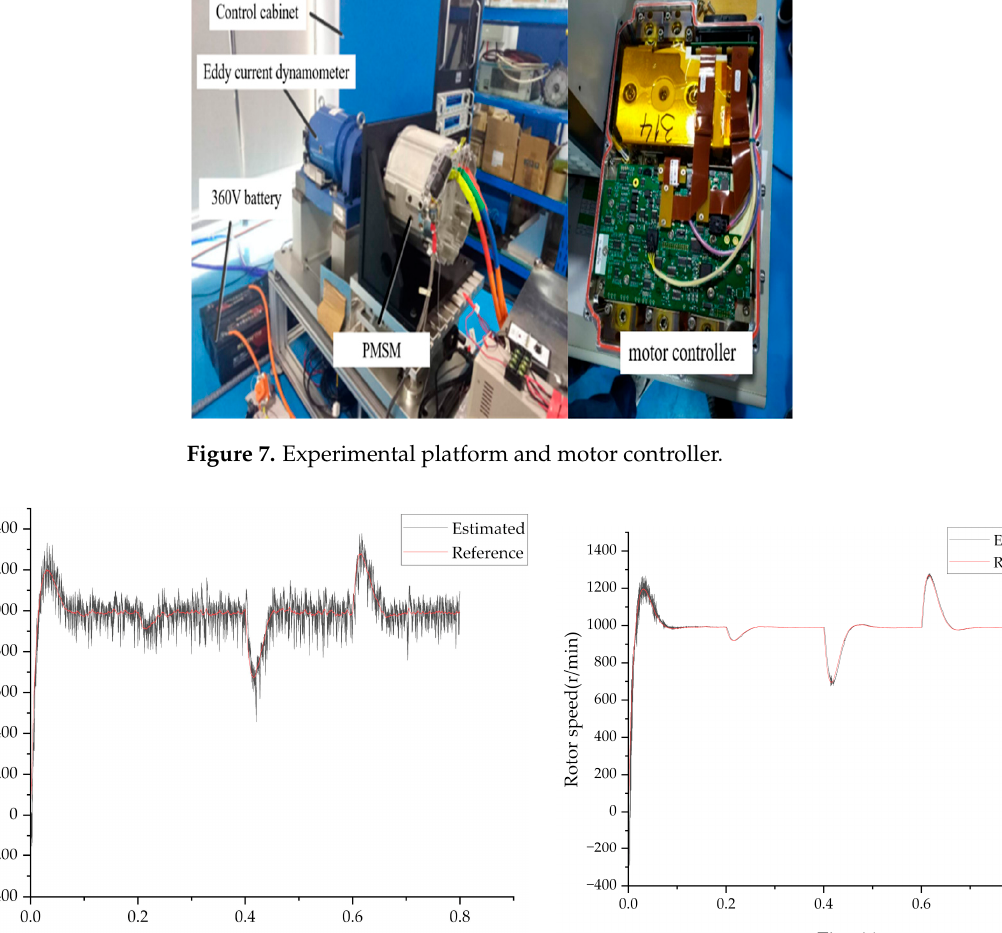
Figure 6. Simulation results of three-phase current. ( a ) Traditional sliding mode observer, ( b ) new sliding mode observer.